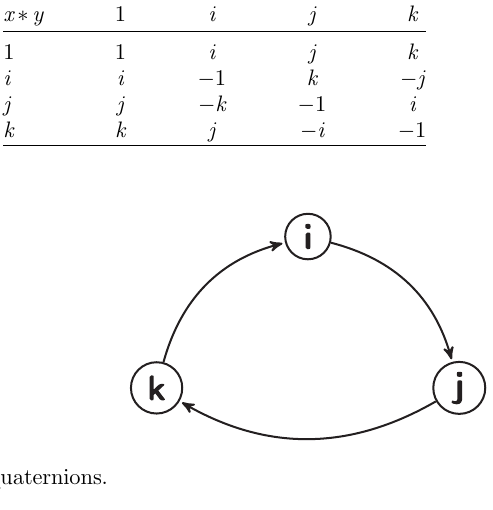
Figure 2. Diagram of Fano for quaternions.